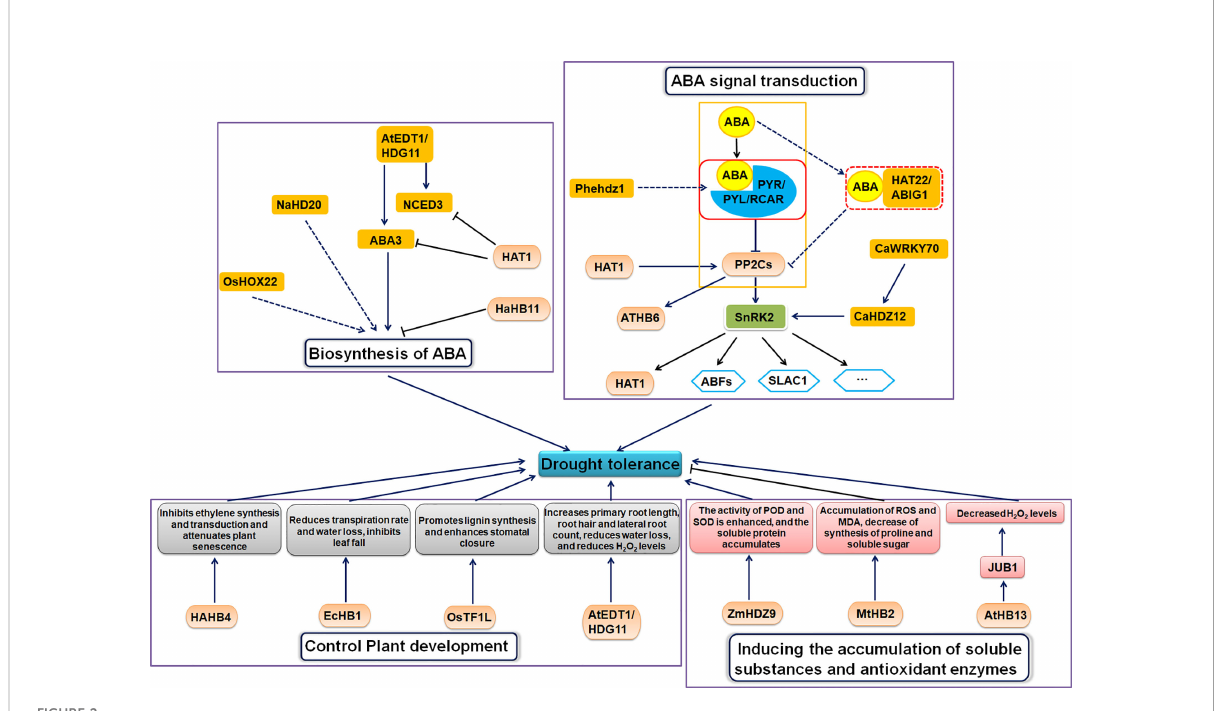
FIGURE 2 Molecular mechanism of HD-ZIP protein under drought